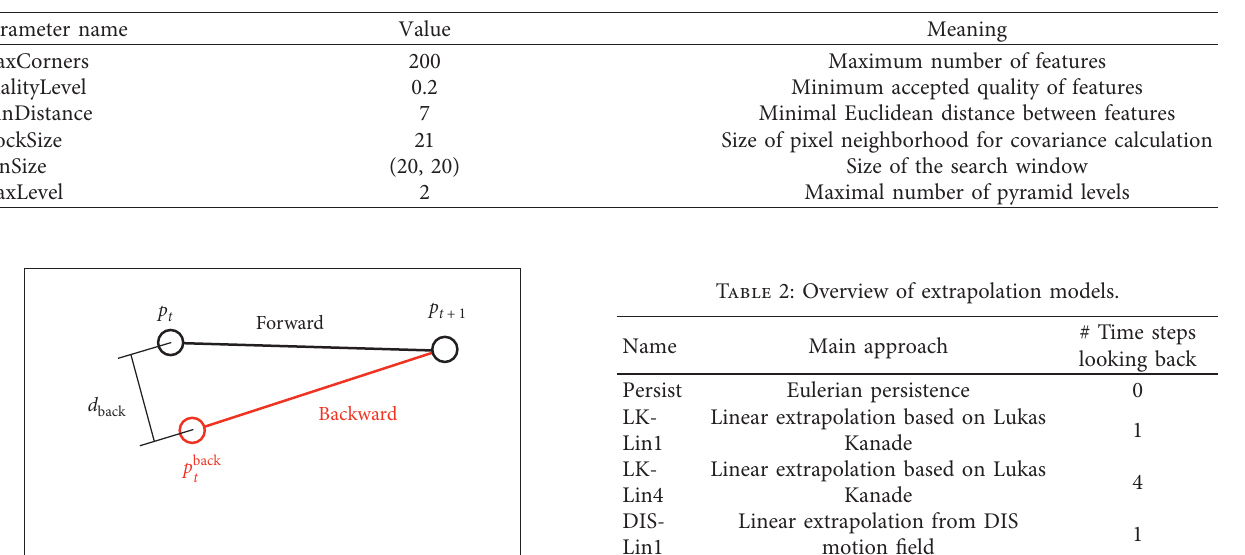
Table 1: OpenCV function parameters used for feature detection and tracking.